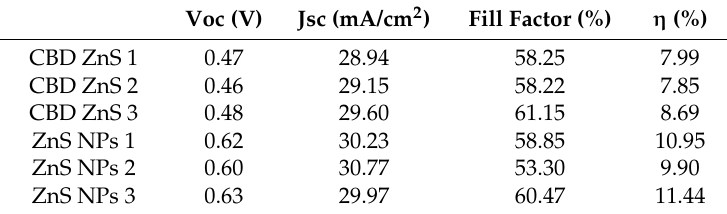
Figure 2. ( a ) A schematic illustration on compact layer of ZnS nanoparticles layer on Cu(In,Ga)Se 2 (CIGS) surface. ( b ) Current–voltage (J–V) characteristic curves of CIGS solar cells with chemical bath deposition (CBD) ZnS buffer layer and ZnS NPs buffer layer. J–V curves of ZnS NPs devices are presented in pink, red and wine red, while curves obtained from CBD ZnS devices are presented in blue, light blue and navy blue. Absorber layers of the two kinds of CIGS solar cells were separately prepared by co-evaporation. Inset shows a schematic illustration on the device structure. ( c ) J–V curve of Champaign CIGS solar cell with ZnS NPs buffer layer. Table 1. Parameters of CIGS solar cells with CBD ZnS buffer layer and ZnS NPs buffer layer. Voc